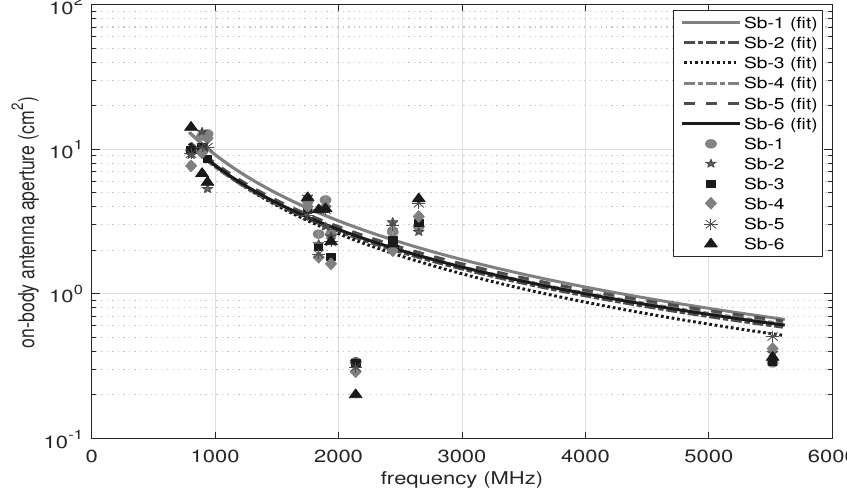
Figure 6. The fitted models to the on-body AA values for six people. Vertical axis: frequency (MHz), horizontal axis: AA (cm 2